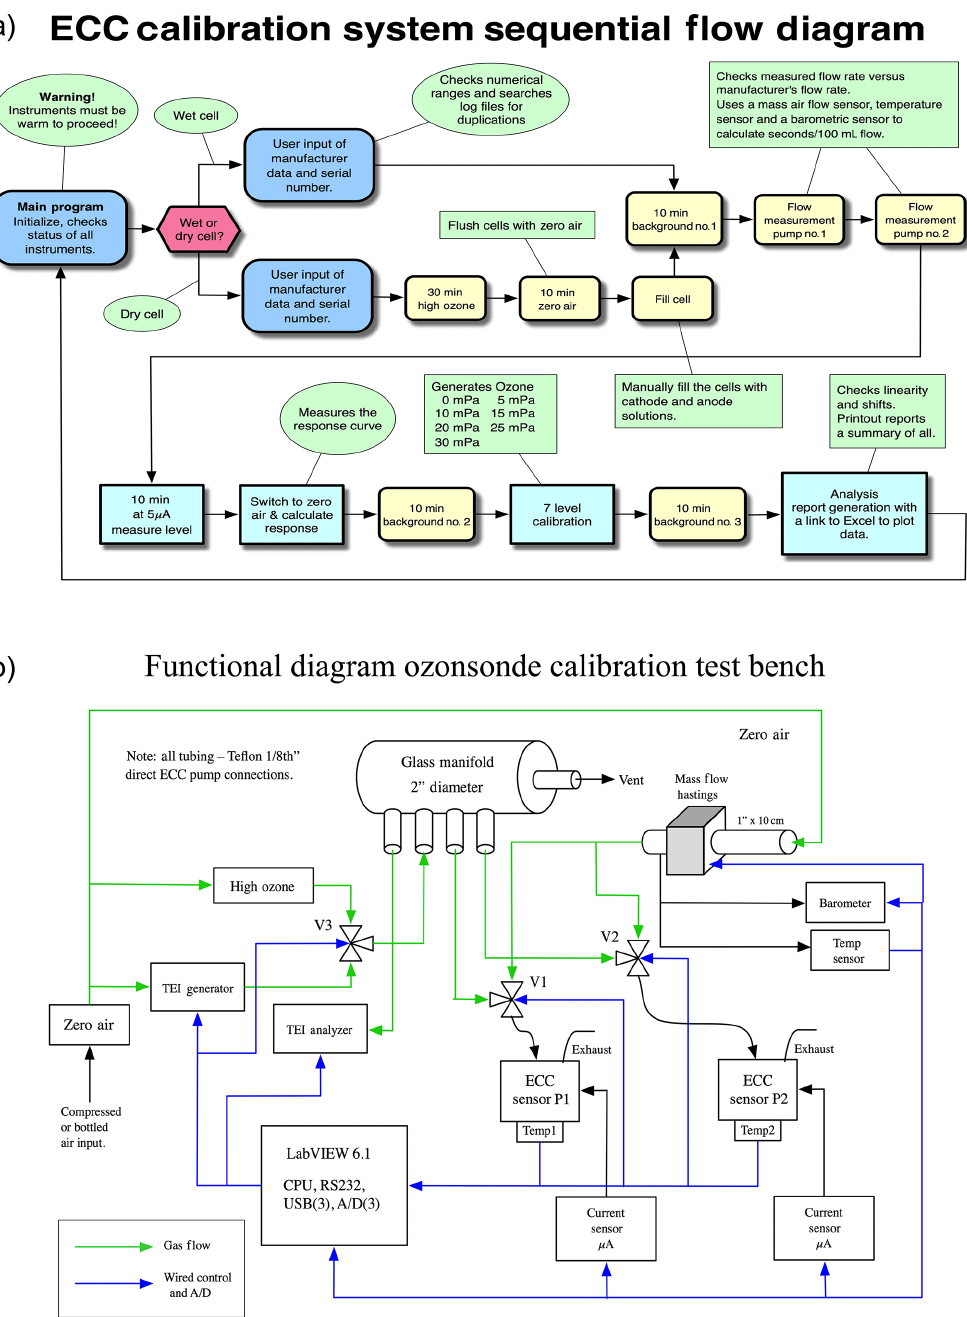
Figure 2. Digital calibration bench diagrams: (a) sequential steps and (b) functional steps (source: unpublished technical note, Tony Baldwin, personal communication,